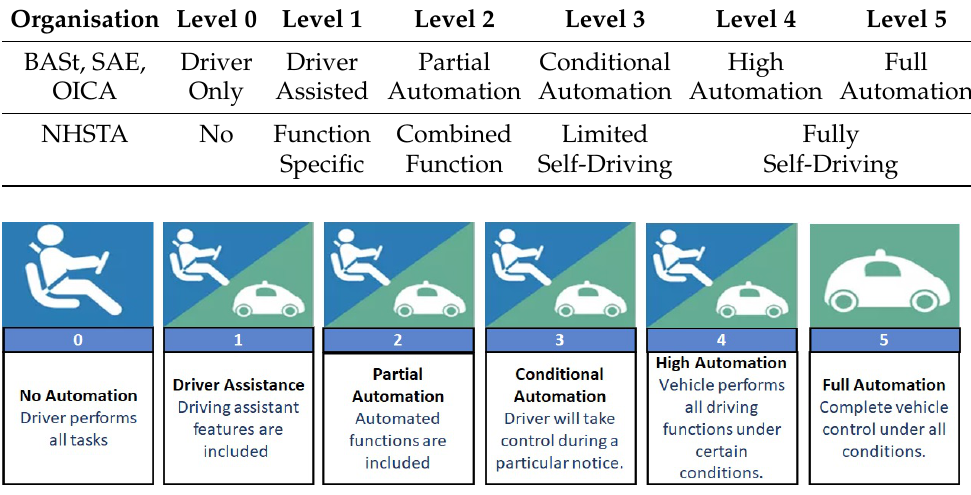
Figure 3. Different levels of